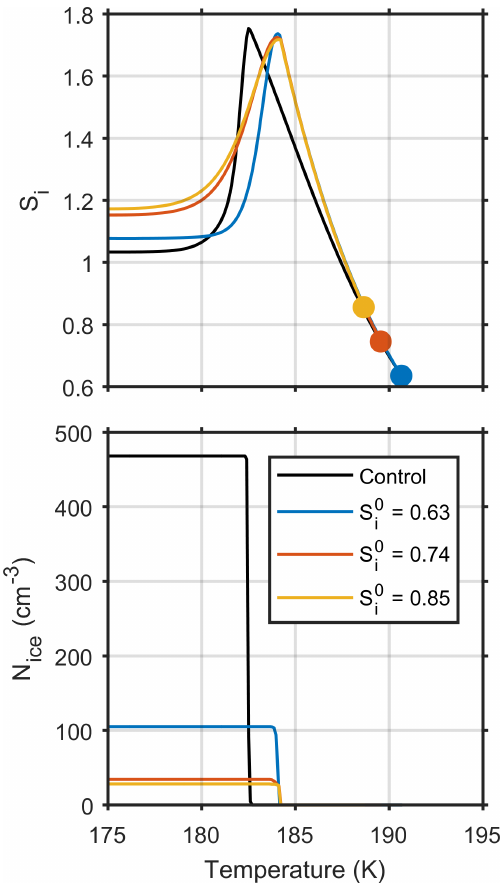
Figure 6. The effect of different initial ice supersaturations, S i , on model simulations initiated with aerosol size distribution 3 and a constant updraft velocity of 0.6ms − 1 .